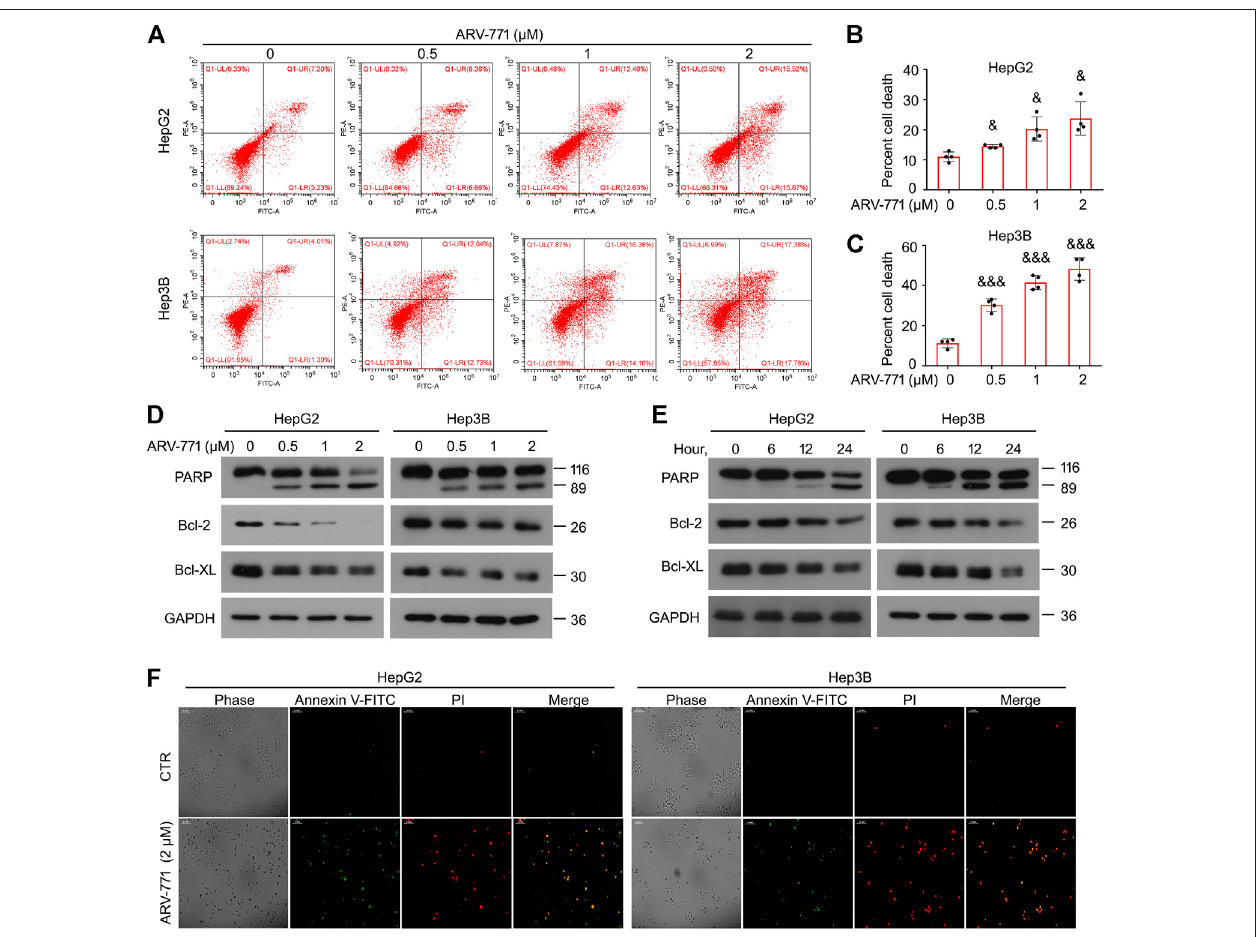
FIGURE 3 | ARV-771 triggers apoptosis in HCC cells. (A) Apoptosis assays were performed in HepG2 and Hep3B cells post the treatment of ARV-771 for 24 h (B) – (C) Quantitativecell deathwasshown. & p < 0.01, &&& p < 0.0001. (D) Immunoblot assaysfortheindicatedapoptosis-associated proteins wereperformedin HepG2 and Hep3B cells treated with ARV-771 (0.5, 1, 2 μ M) for 24 h. (E) Immunoblot assays for the indicated apoptosis-associated proteins were performed in HepG2 and Hep3B cells treated with ARV-771 (2 μ M) for 6, 12, and 24 h. (F) Annexin V-FITC/PI staining assays were performed in HepG2 and Hep3B cells treated with ARV- 771 for 24